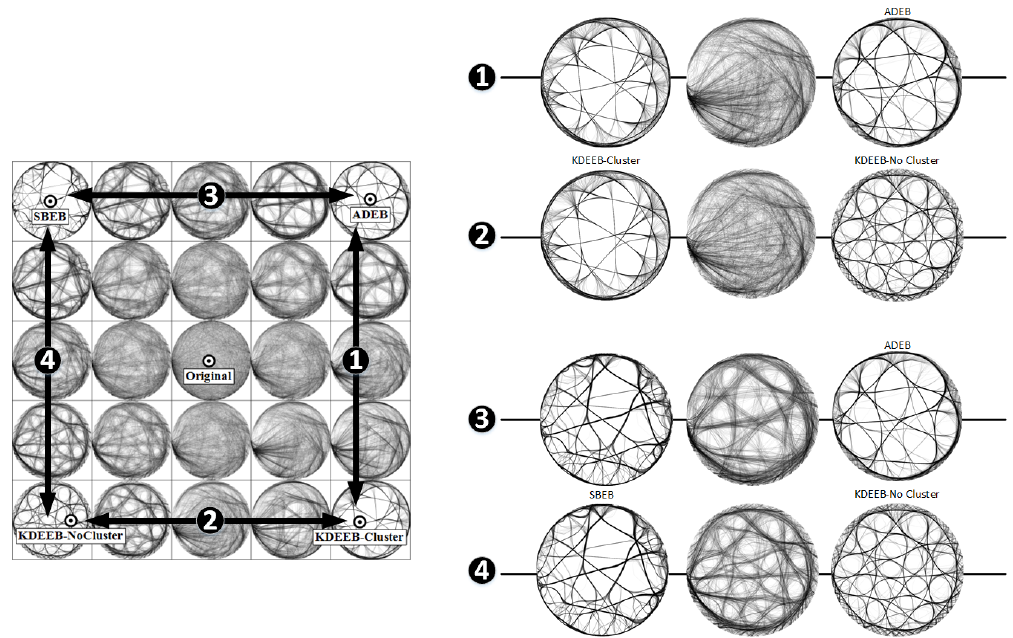
Figure 9. Understanding differences between several EB techniques. The transition between KDEEB-cluster and any other technique produces fuzzy intermediate states (1 and 2), while the transition between SBEB and the othe techniques produces sharper images (3 and 4). This shows that KDEEB-Cluster is visually very different from the other clustering techniques